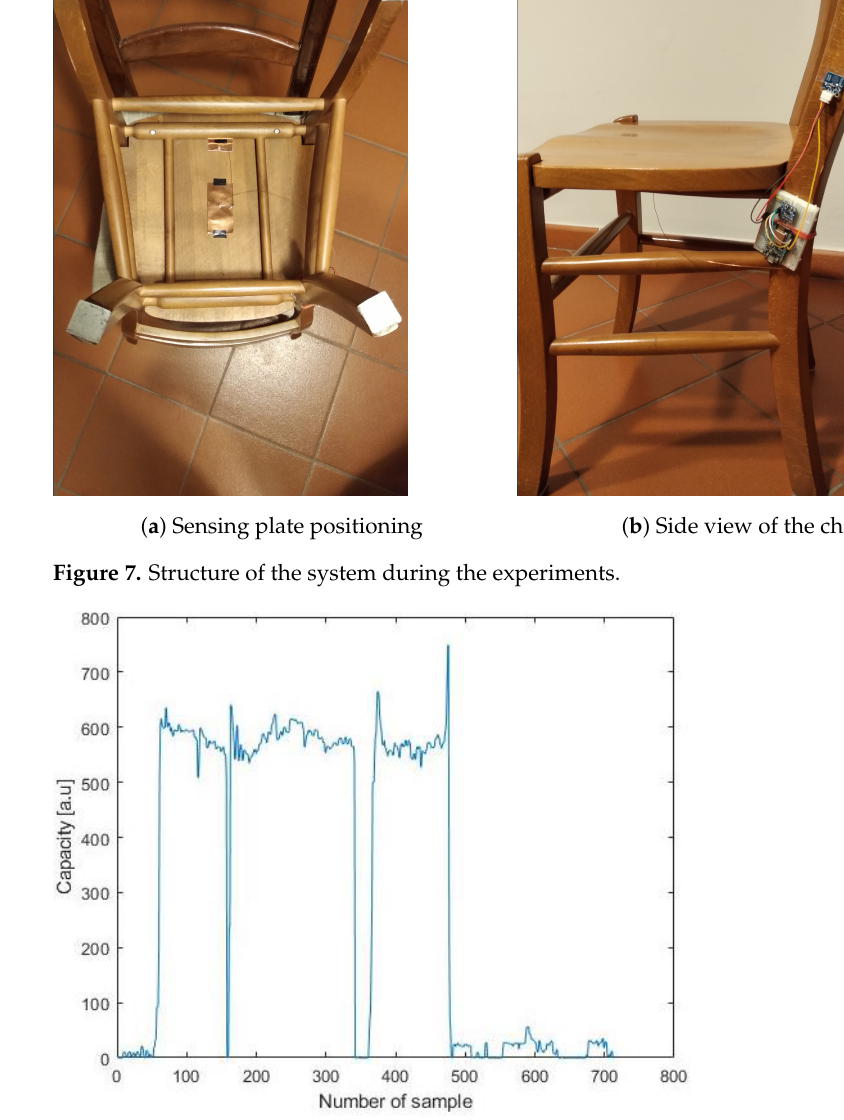
Figure 8. Graph of the capacity during the test. Table 3. Confusion Matrix of the first